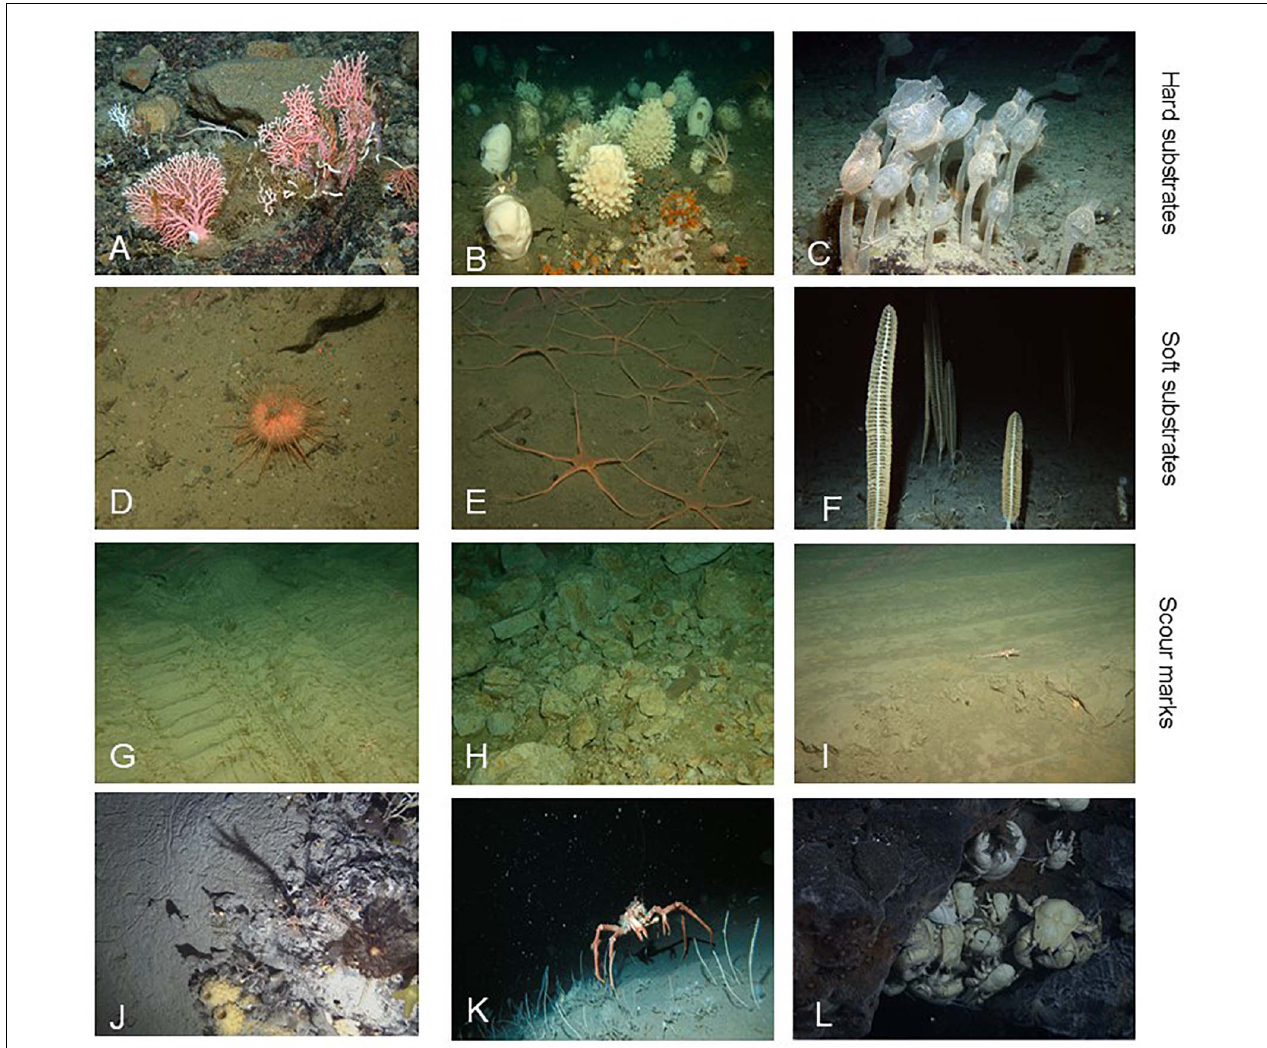
FIGURE 5 | Examples of different benthic habitats, species and scouring impacts. Where, first row = fauna associated with hard substrate on the Antarctic shelf including: A = corals, B = sponges, C = sea squirts, second row = fauna associated with soft sediments on the Antarctic shelf where D = sea urchin, E = brittle stars, F = sea pens, third row = scour marks, fourth row, J = edge of retreating glacier Marian Cove (King George Island), K = spider crab, L = yeti crabs at hydrothermal vents. Image sources: J. Gutt, A. Starmans, W. Dimmler, AWI, www.pangaea.de (A–I,K) , Dave Barnes (J) , NERC ChEsSo Consortium, Rogers et al. (2020) (L)